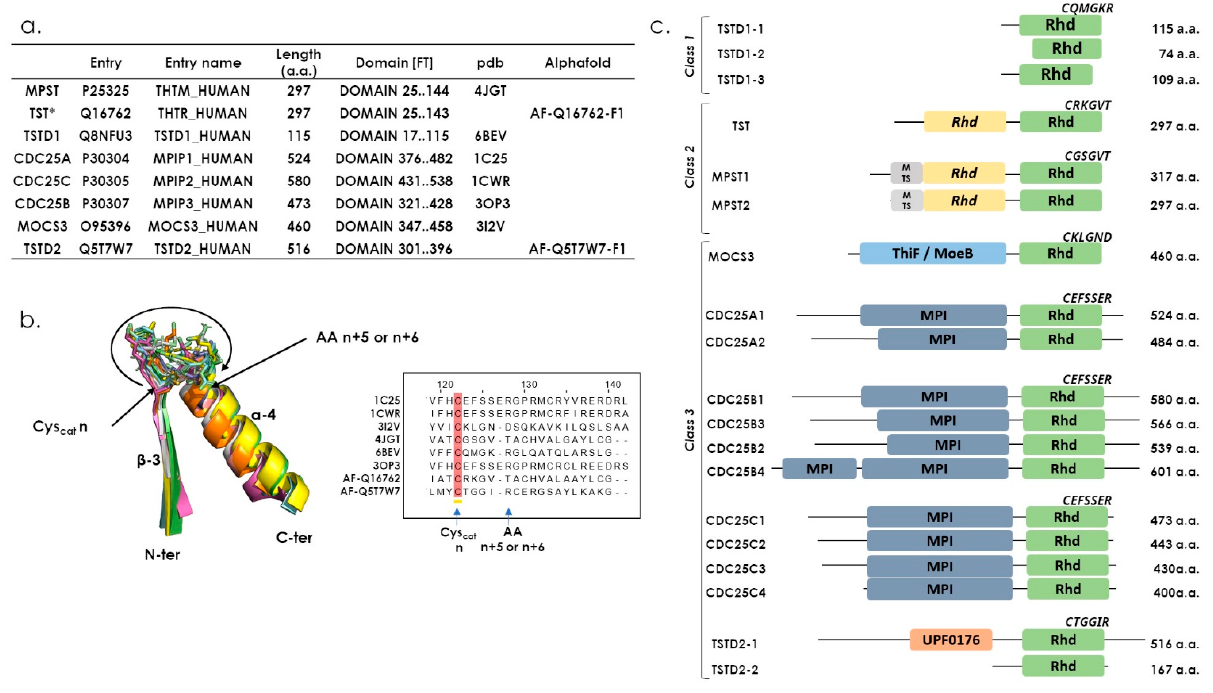
Figure 3. Human-active Rhd domain-containing proteins. ( a ) Eight human Rhd domain-containing proteins retrieved from the Uniprot database (https://www.uniprot.org/, accessed on 15 September 2022), indicating the length of the proteins and the position of the Rhd domain within the sequences. 3D-structures available in PDB, experimentally resolved or predicted structures by alphafold (https://alphafold.ebi.ac.uk/ accessed on 18 October 2022) are indicated. TST* is also known as Rhodanese. ( b ) Superimposition of active site loops (in sticks) flanked by the β -3 strand and the α -4 helix was made using CCP4MG software (https://www.ccp4.ac.uk/MG/ accessed on 5 July 2022) and is represented using Pymol (https://pymol.org/2/, version 2.4.1, accessed on 5 July 2002). Sequence alignment extracted from structure superimposition is represented in the right panel. ( c ) Modular organization of human-active Rhd domain-containing proteins and of their described isoforms. Active site loop sequences are indicated, and protein domains were defined using InterPro (https://www.ebi.ac.uk/interpro/, accessed on 25 September 2022). Among the eight active Rhd-containing proteins, four catalyze a sulfur transfer reac- tion (MPST, TST, TSTD1, MOCS3) and three catalyze phosphatase reactions